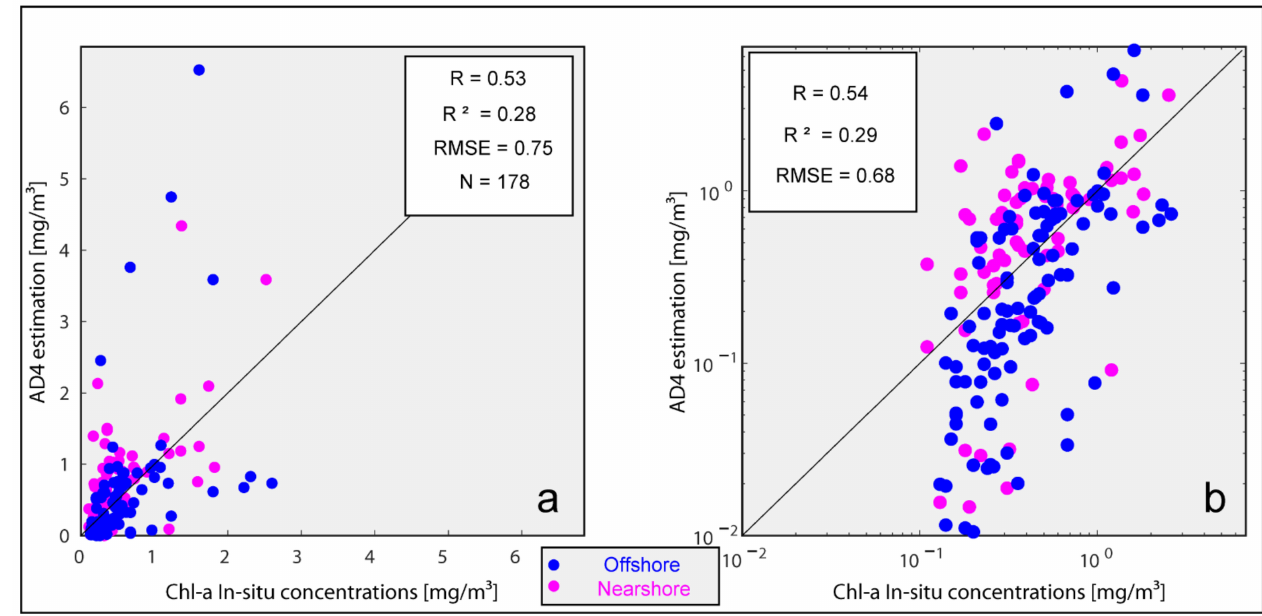
Figure 7. ( a ) Scatter plot of in-situ Chl- a concentrations versus AD4 Chl- a estimates. ( b ) Same in logarithmic scale. The offshore and nearshore stations (Figure 1) are in blue and magenta colors, respectively. Table 1. Statistical analysis (R, R 2 , RMSE and p-value) for the original (OC4Me, NN, OC3E, OC4E, MedOC4, ADOC4, AD4, 3B-OLCI, 2B-OLCI and G2B) and recalibrated (OC4SI, OC3SI, AD4SI, G2B-SI, 2b-OLCI-SI, 3B-OLCI-S) Chl- a algorithms.